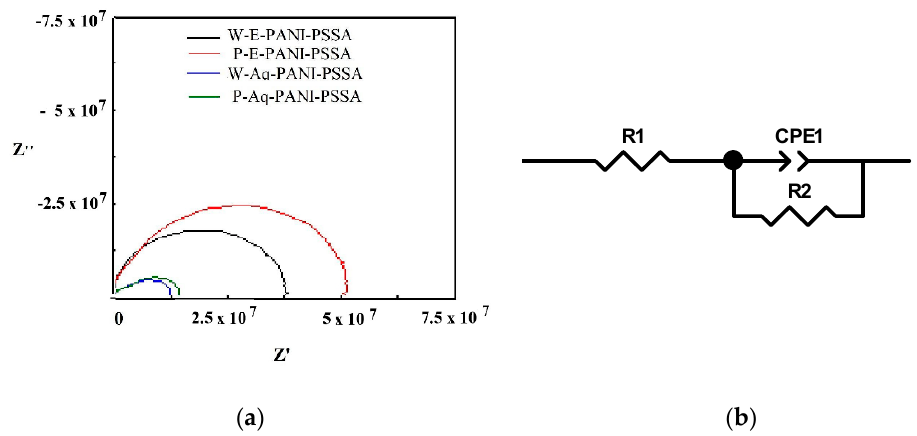
Figure 4. ( a ) Nyquist plots of the coated textiles and. ( b ) Model of circuit fitted based on Nyquist